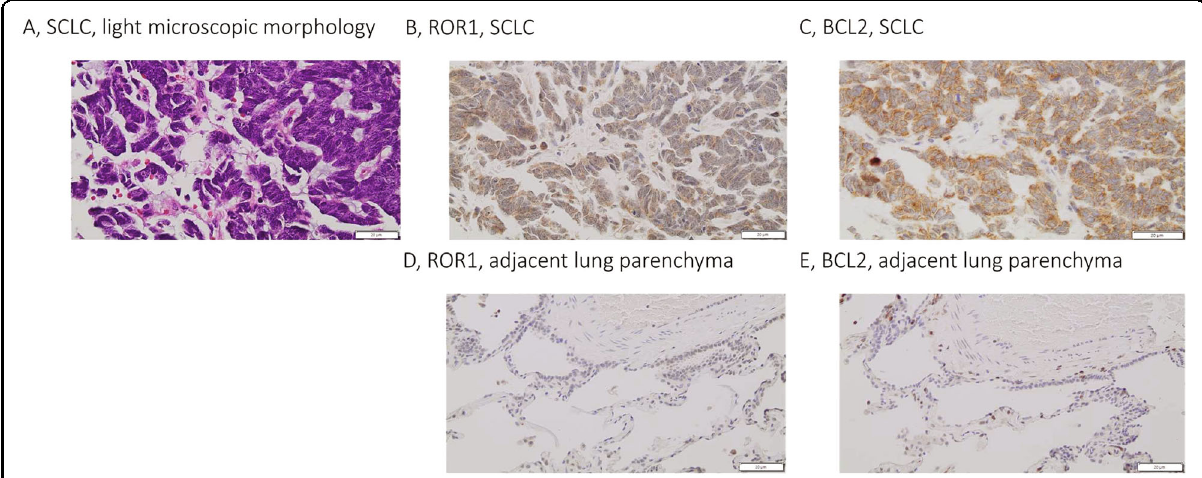
Fig. 1 ROR1 and BCL2 expression in small cell lung carcinoma (SCLC). Light microscopic morphology of a representative case of SCLC ( A ) showing co-expression of ROR1 ( B ) and BCL2 ( C ) in the same tissue core of a tissue microarray; original magni fi cation x400. No expression of ROR1 and BCL2 is observed in non-neoplastic lung parenchyma stained for ROR1 ( D ) and BCL2 ( E ); the same tissue core, original magni fi cation x400.